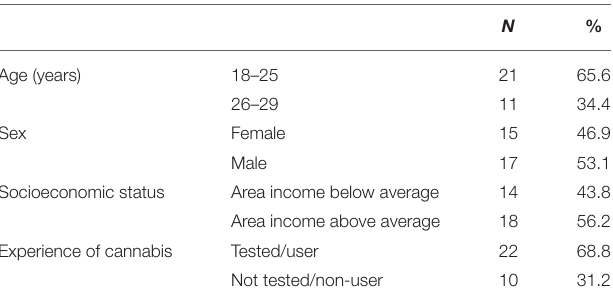
TABLE 1 | Background information about the